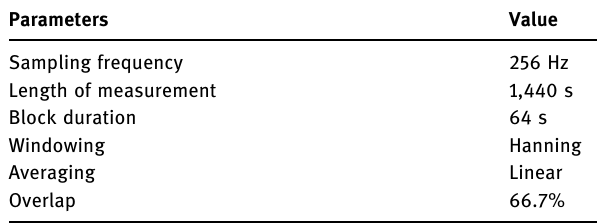
Table 1: Acquisition